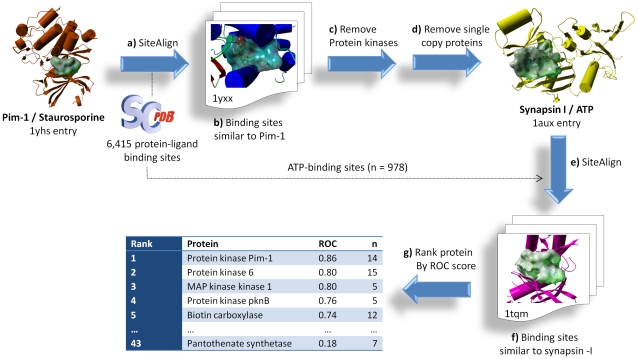
Computational protocol used to detect local similarities between ATP-binding sites in Pim-1 kinase and Synapsin I.a) The ATP-binding site in Pim-1 kinase (occupied by the ligand staurosporine) is compared with SiteAlign [41] (step a) to 6,415 binding sites stored in the sc-PDB database . Among top scoring entries (step b), synapsin I is the only protein not belonging to the protein kinase target family (step c) and present in numerous copies (step d). A systematic SiteAlign comparison (e) of the ATP-binding site in synapsin-I with 978 other ATP-binding sites suggest that some but not all ATP-binding sites of protein kinases (steps f, g) are similar to that of synapsin I.